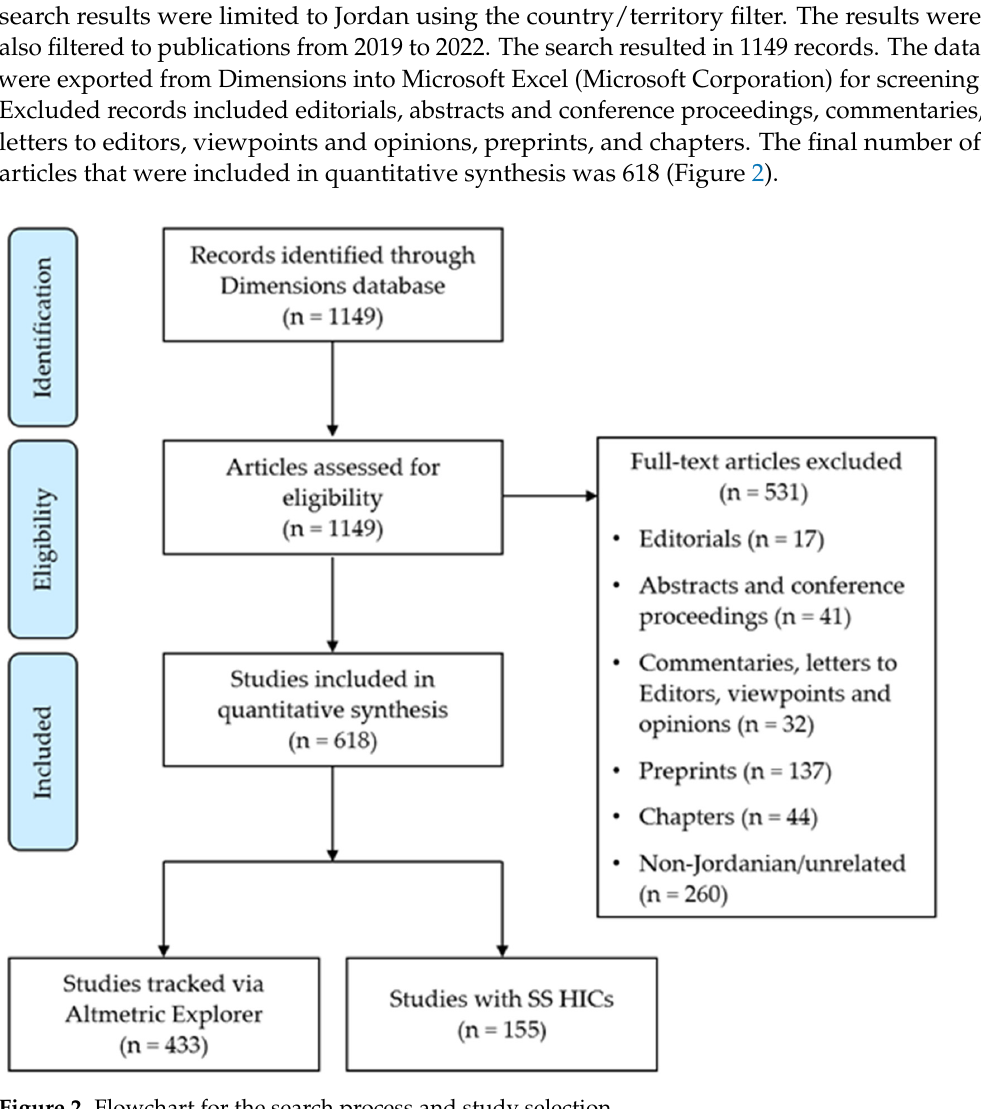
Figure 2. Flowchart for the search process and study selection.